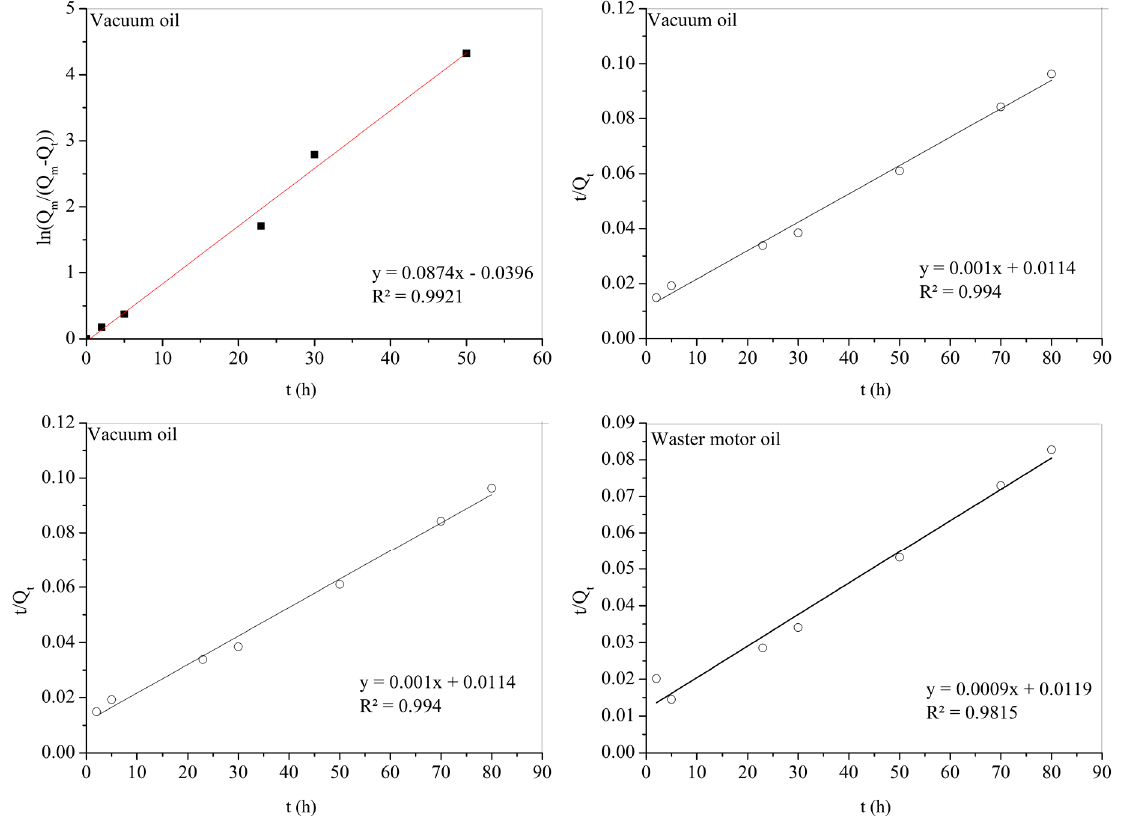
Table 3. Summary of the maximum oil absorption capacities and the absorption rate constants of the SCA using the pseudo-first-order and pseudo-second-order models.